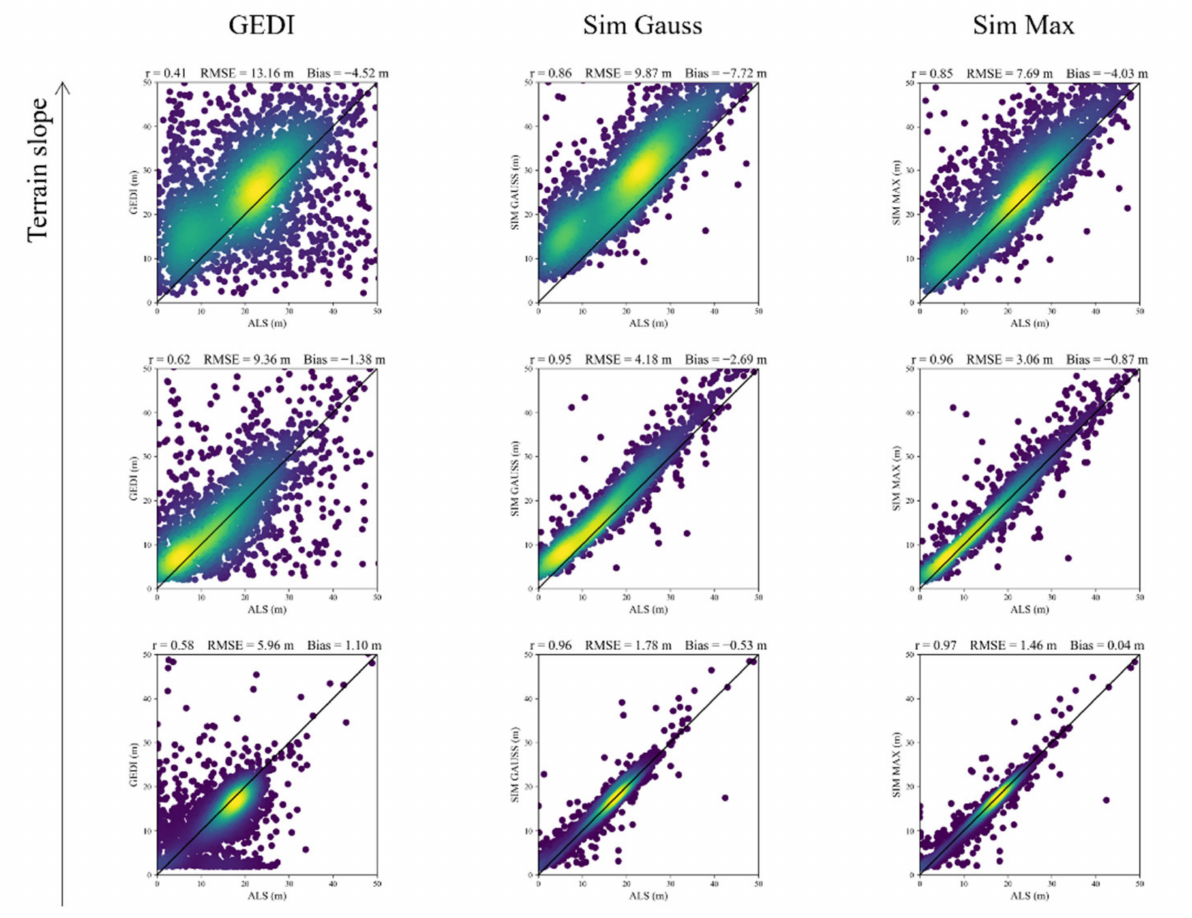
Figure 7. Intercomparison of GEDI ( left column), Gaussian simulator (centre column), and Maximum simulator ( right column) with the RH95 benchmark values, for terrain slopes of 0–5 degrees ( bottom row), 15–20 degrees ( centre row), and >30 degrees ( top